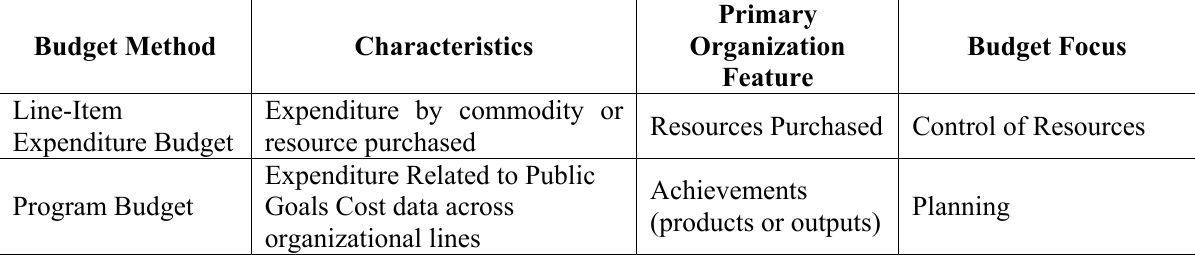
Table 1. The main differences between the traditional line-item budget method and the program